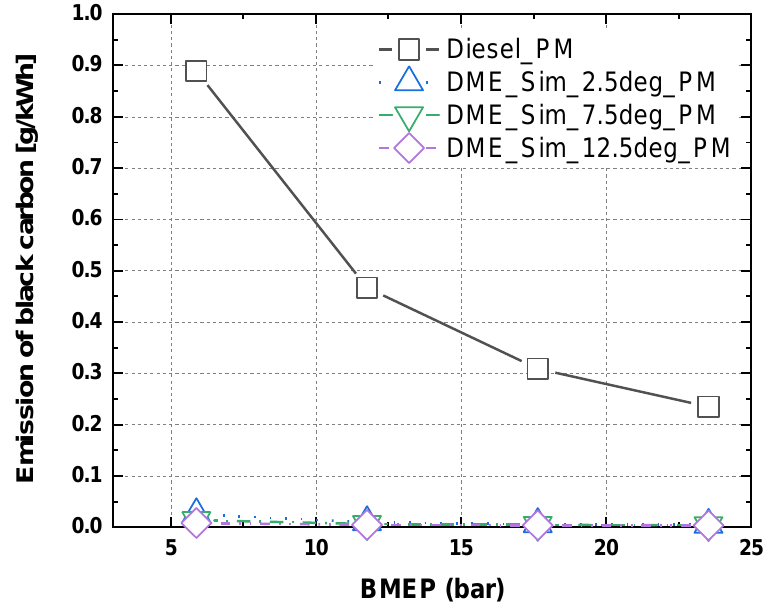
Figure 8. Characteristics of black carbon emission versus start of injection timing for marine diesel fuel and DME fuel.